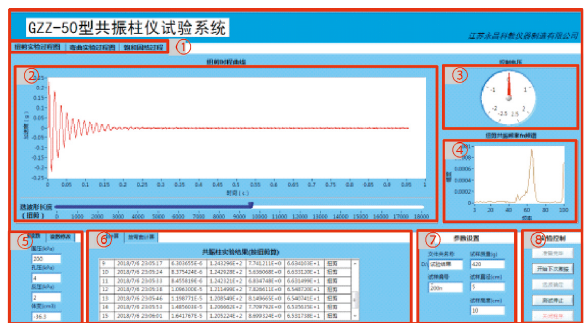
Figure 15: Functional division of free-vibration column of GZZ- 50: ① test type, ② data records of accelerometer, ③ exciting force of drive board, ④ results of Fourier transform, ⑤ date records of other information, ⑥ results of test, ⑦ test parameters, and ⑧ test